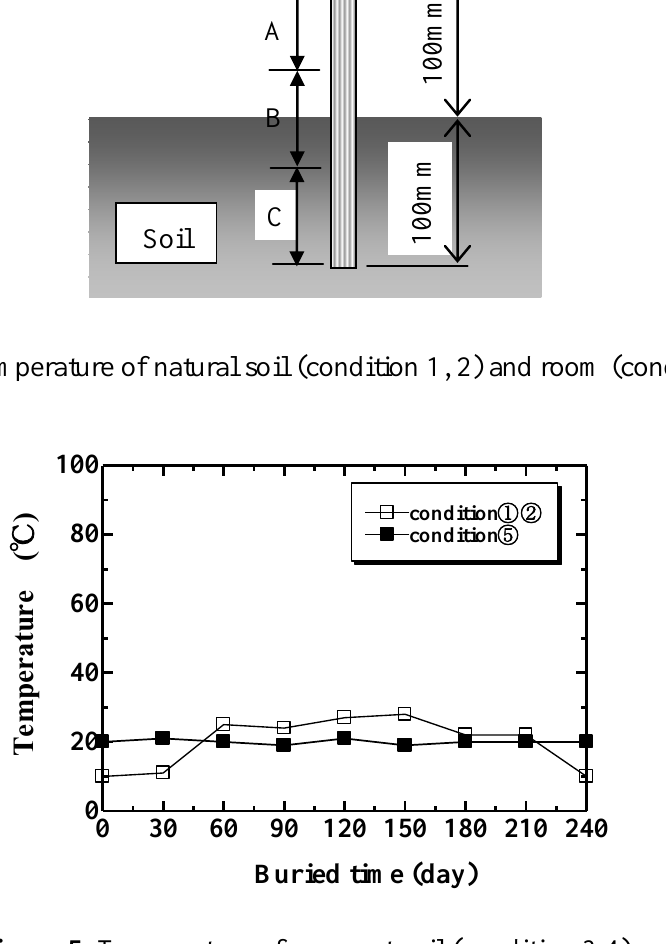
Figure 5. Temperature of compost soil (condition